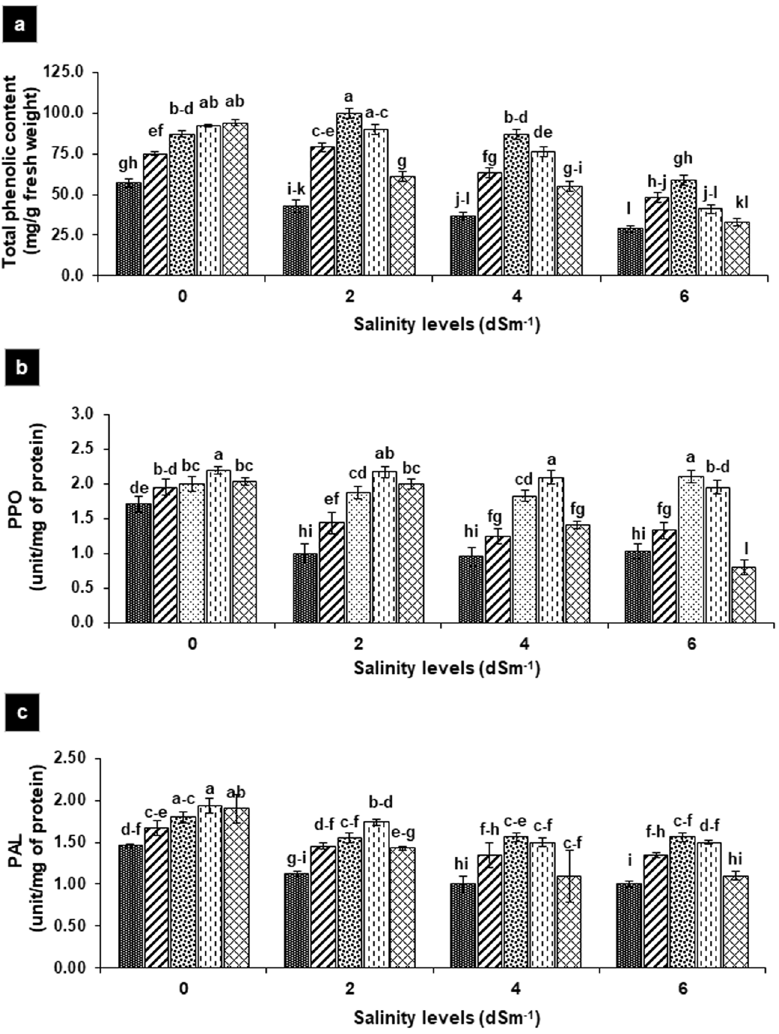
Figure 6. (a – c) Effects of foliar application of salicylic acid on total phenolics ( a ), PPO activity ( b ) and PAL activity ( c ) in Gladiolus grandiflorus irrigated with saline water. Vertical bars show standard errors of means of three replicates. Different letters indicate significant differences (P < 0.05) according to LSD test; the same letter indicates no significant differences between the